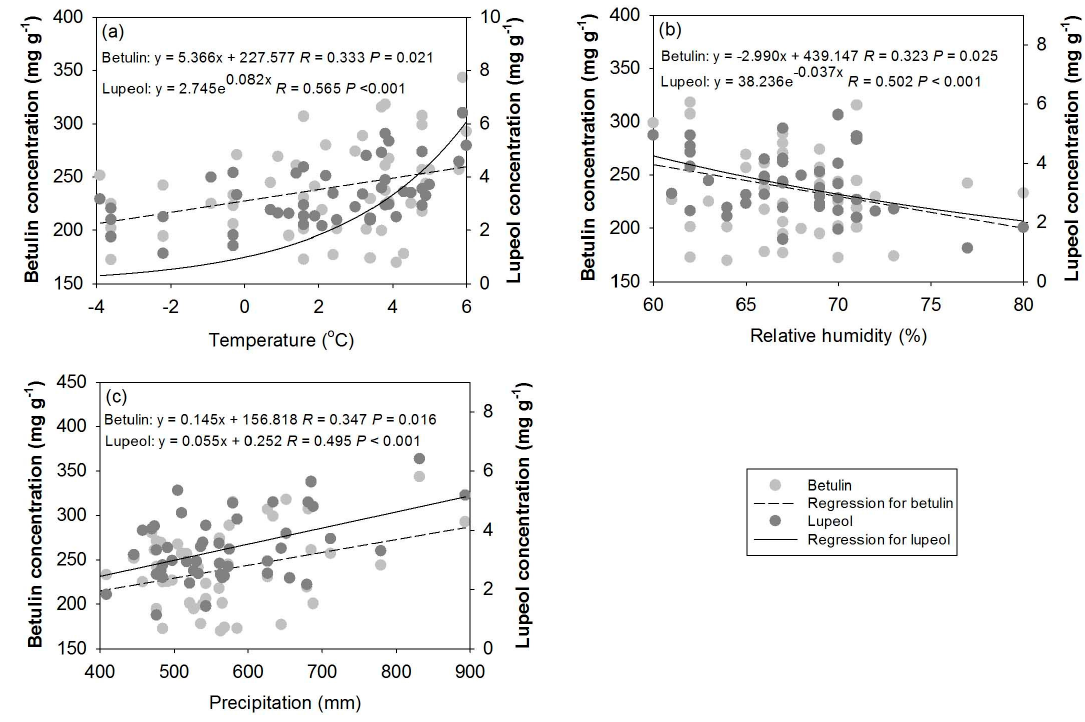
Figure 4. Regressions between climatic factors of temperature ( a ); relative humidity ( b ) and precipitation; ( c ) and betulin and lupeol concentrations in barks of white birch trees in Northeast China ( n = 48).